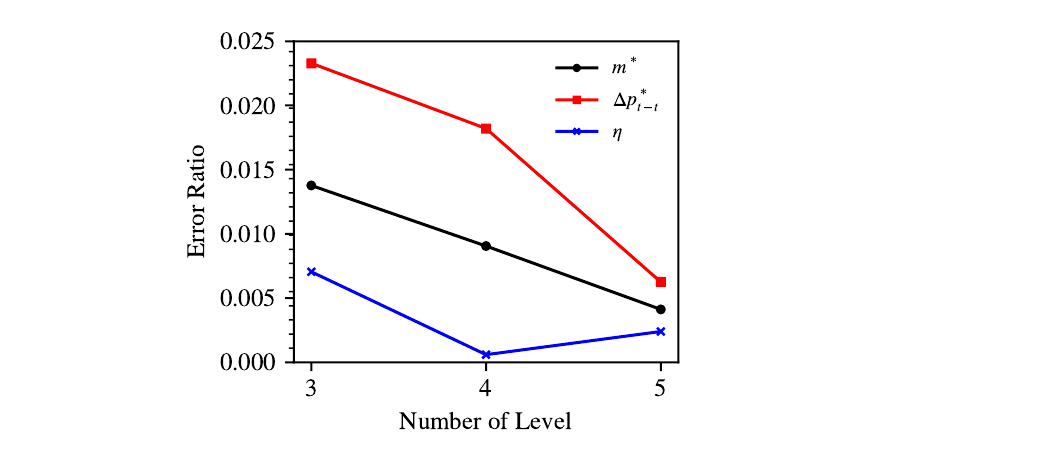
Figure 6. Error ratios of flow coefficients, total-to-total pressure rises and efficiencies compared to the reference data.